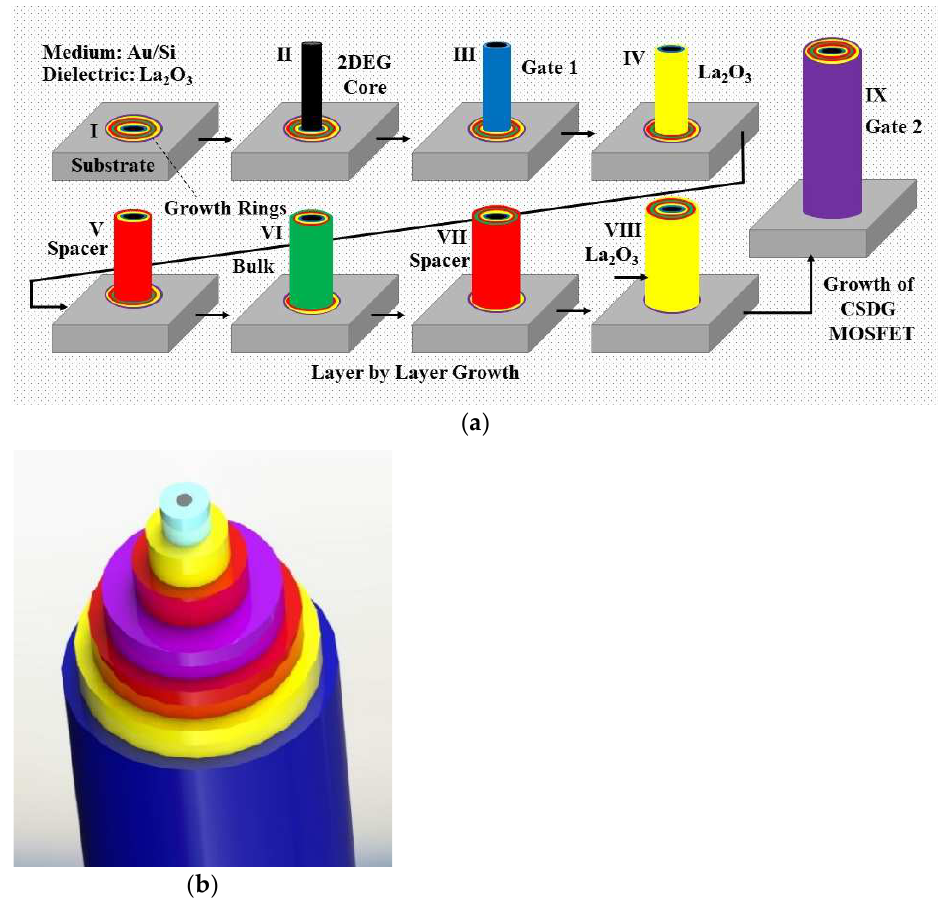
Figure 3. Fabrication of the CSDG MOSFET in a controlled environment [45,46]: ( a ) step-by-step proposed procedure; ( b ) final CSDG MOSFET after fabrication showing concentric cylindrical structure.